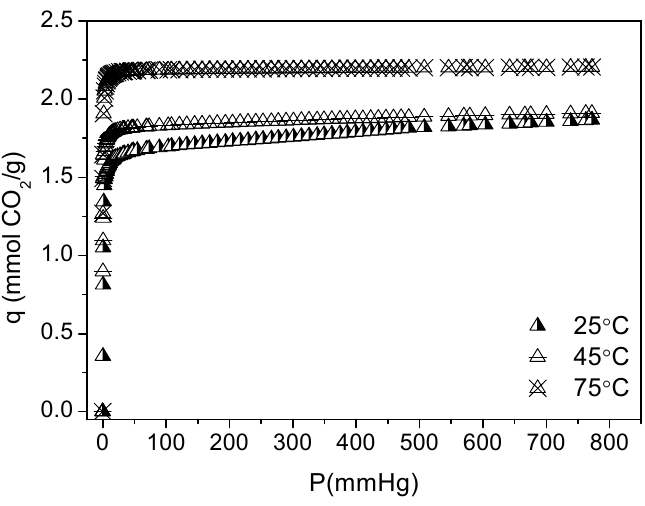
Figure 9. CO 2 adsorption isotherms for TiPB-F/50 PEI at 25, 45 and 75 °C.